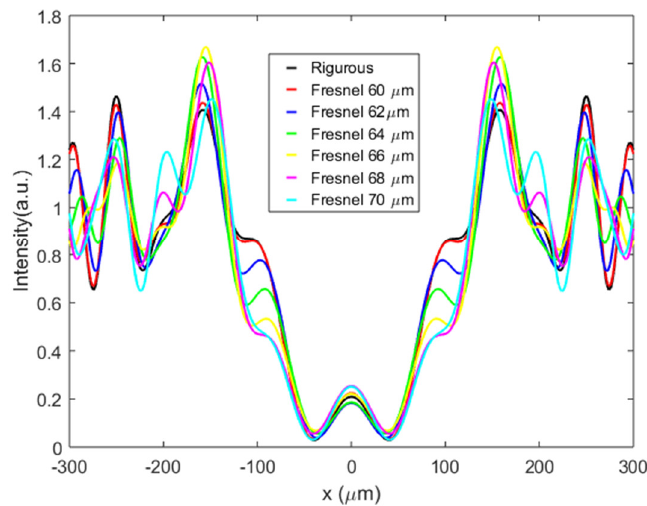
Figure 10. Intensity of the diffraction pattern as function of the distance to the center of the diffraction pattern for a dielectric cylinder with refractive index n = 1.50 and internal radii of 60, 62, 64, 66, 68, and 70 µm.